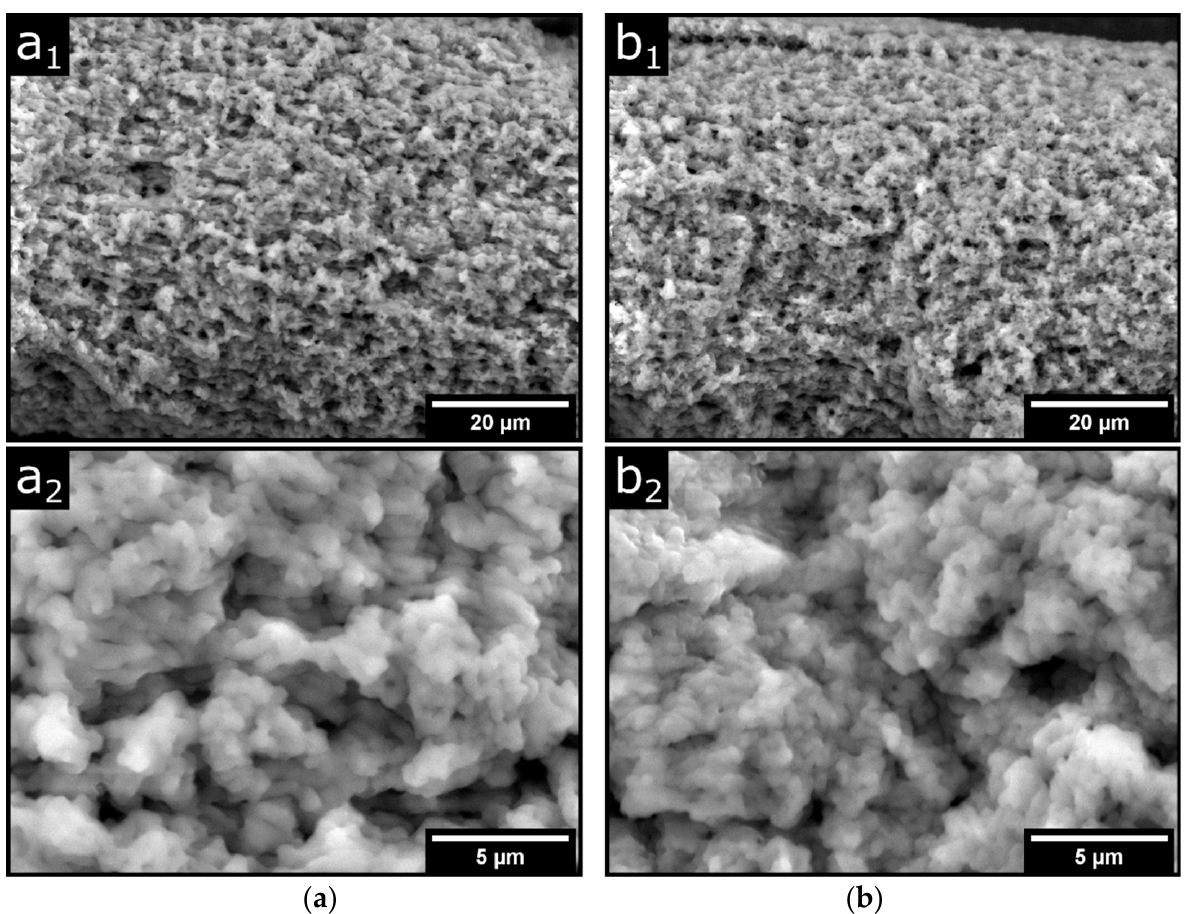
Figure 3. Scanning electron micrographs of dried p -CMs fibers ( a ) without and ( b ) with TGase treatment. ( a 1 ) and ( b 1 ): × 2000 magnification, ( a 2 ) and ( b 2 ): × 8000 magnification.